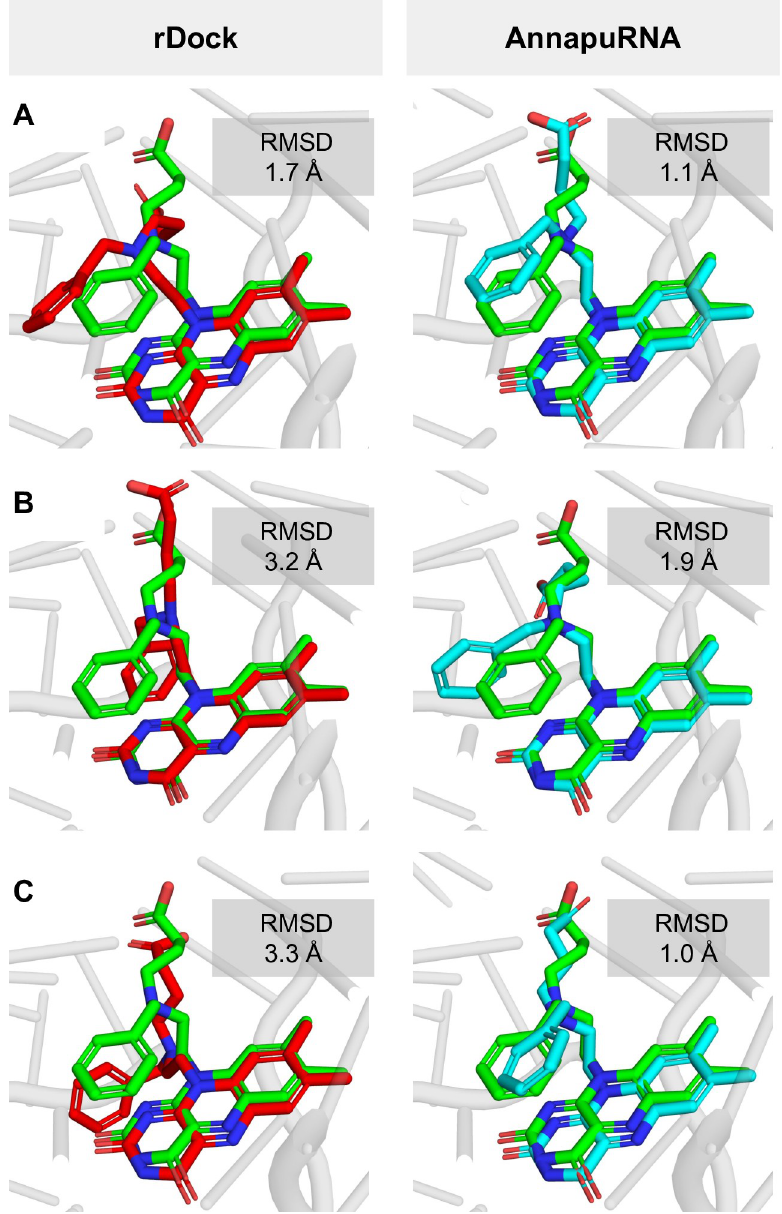
Fig 7. Prediction of the complex of FMN Riboswitch with 4-{benzyl[2-(7,8-dimethyl-2,4-dioxo-3,4-dihydrobenzo [g]pteridin-10(2H)-yl)ethyl]amino}butanoic acid. ( A). Redocking experiment—ligand extracted from the crystal structure 6DN2 was redocked to this structure; ( B) . Ligand extracted from the crystal structure 6DN2 docked to FMN structure solved with a different ligand (2YIE); ( C) . Ligand extracted from the crystal structure 6DN2 docked to the low-resolution APO FMN structure (2YIF). All RNA structures are superimposed. The reference ligands structures are shown in green. Structures predicted by rDock (dock_solv) are shown in magenta (left), predicted by AnnapuRNA (DL 2013) in light blue